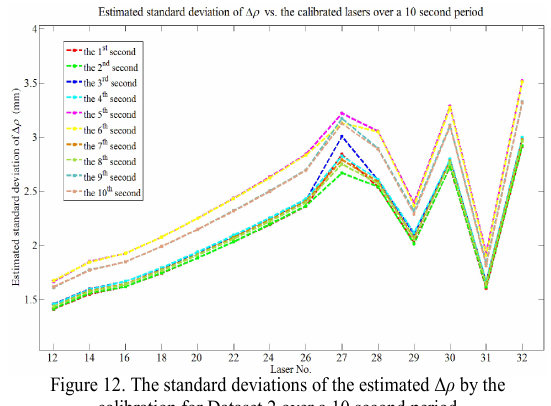
Figure 15. The estimated Δ θ by the calibration for Dataset 2 over a 10 second period